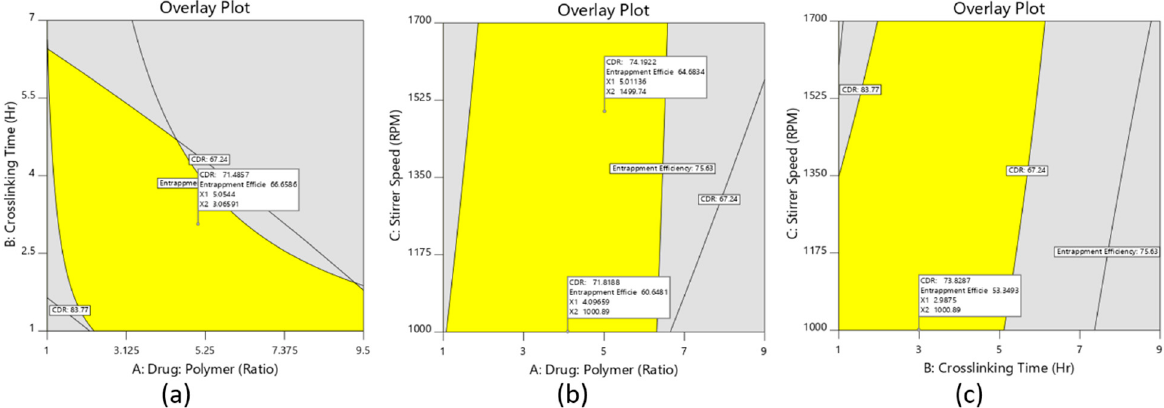
Figure 3. The overlay plots of the nanoparticle formulation, ( a ) overlay plot of the drug-to-polymer ratio and stirrer speed, ( b ) overlay plot of the drug-to-polymer ratio and crosslinking time, ( c ) overlay plot of stirrer speed and crosslinking time. Table 4. Predicted and actual cumulative drug release (%) and entrapment efficiency (%) values of the checkpoint batches.